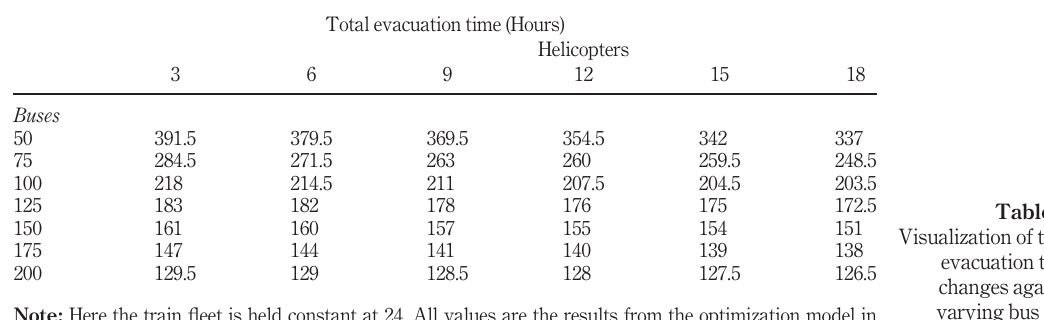
Table 3. Visualization of